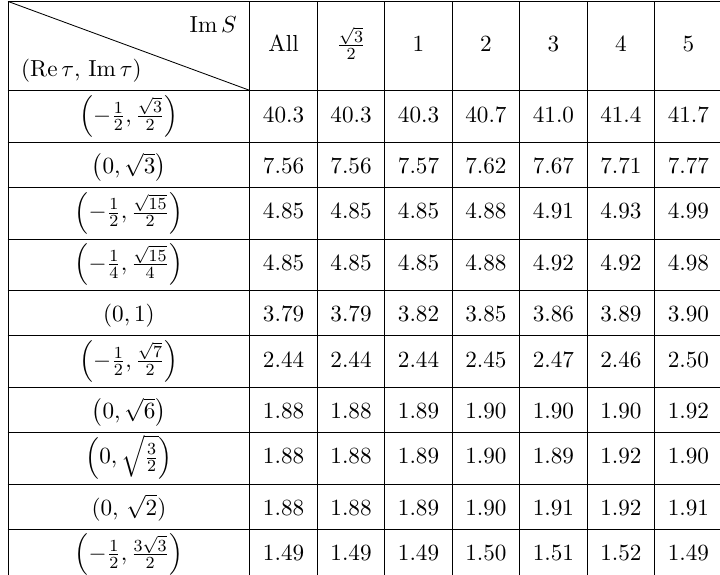
Table 6 . Probabilities (%) of the stable vacua as functions of (Re (cid:28); Im (cid:28) ) and Im S in the descending order of the probability with respect to (Re (cid:28); Im (cid:28) ). Here, we list the probability for N max and the column in \All" corresponds to the probability of table 3.